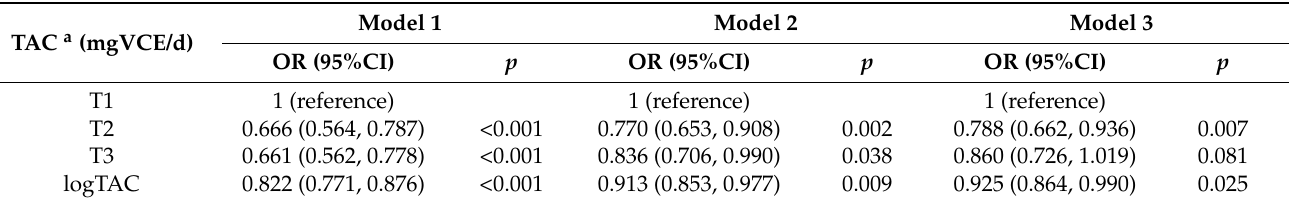
Table 2. Relationship between total antioxidant capacity and the risk of stroke among US